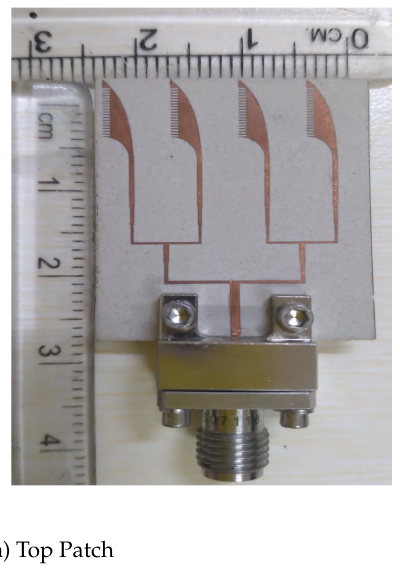
Figure 11. Reflection coefficient of the designed antenna.